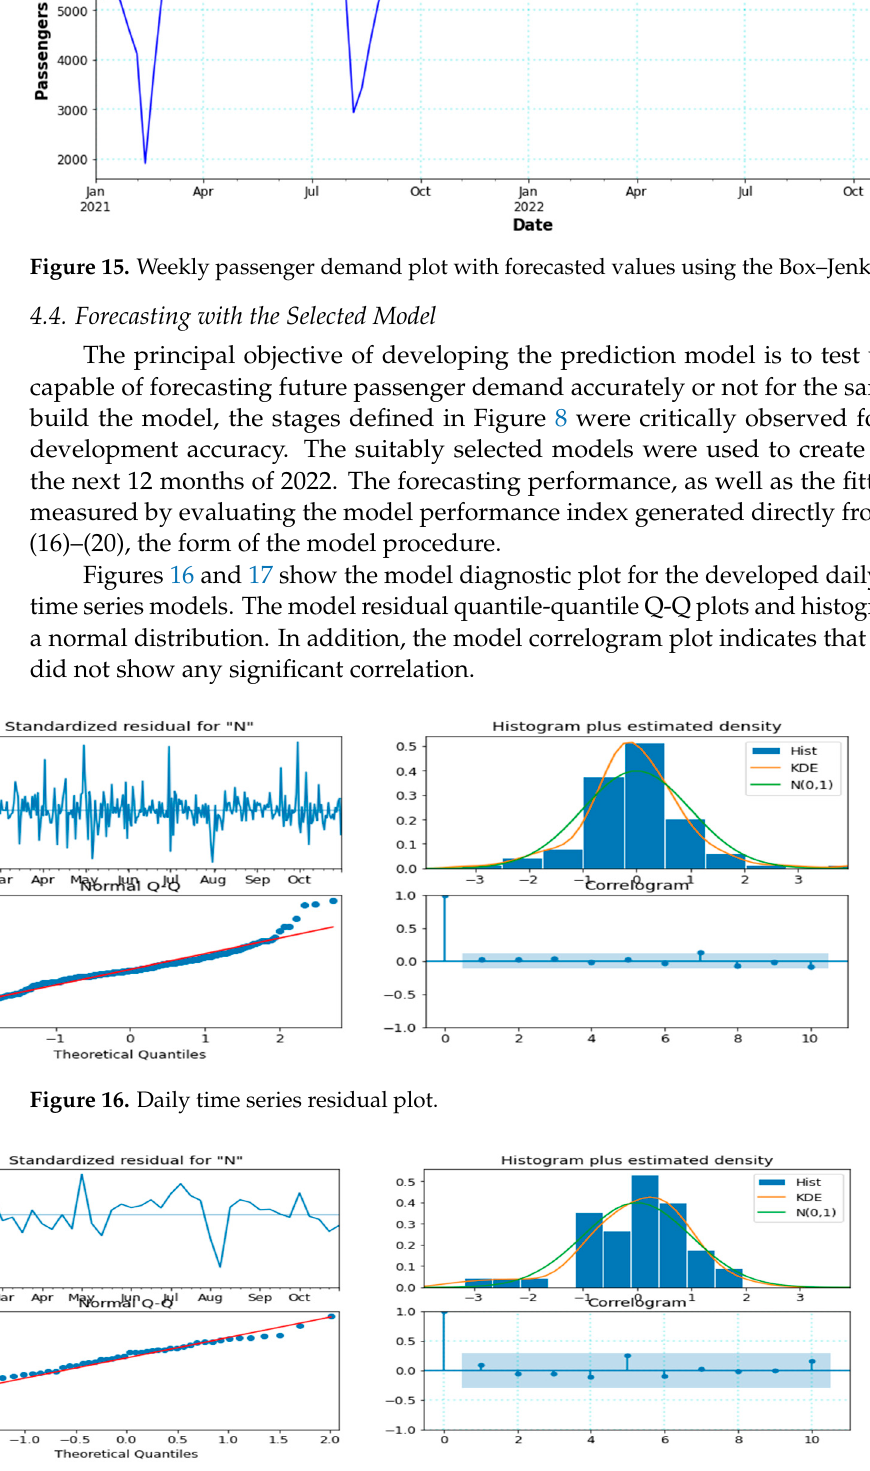
Figure 17. Weekly time series residual plot.